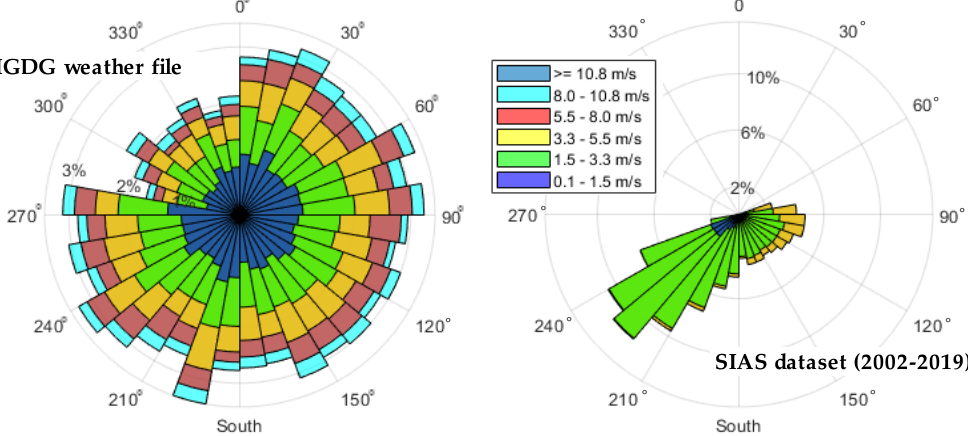
Figure 7. Wind rose for the EnergyPlus website (IGDG) weather file (left-hand side) and for the entire long-term SIAS dataset (right-hand side).